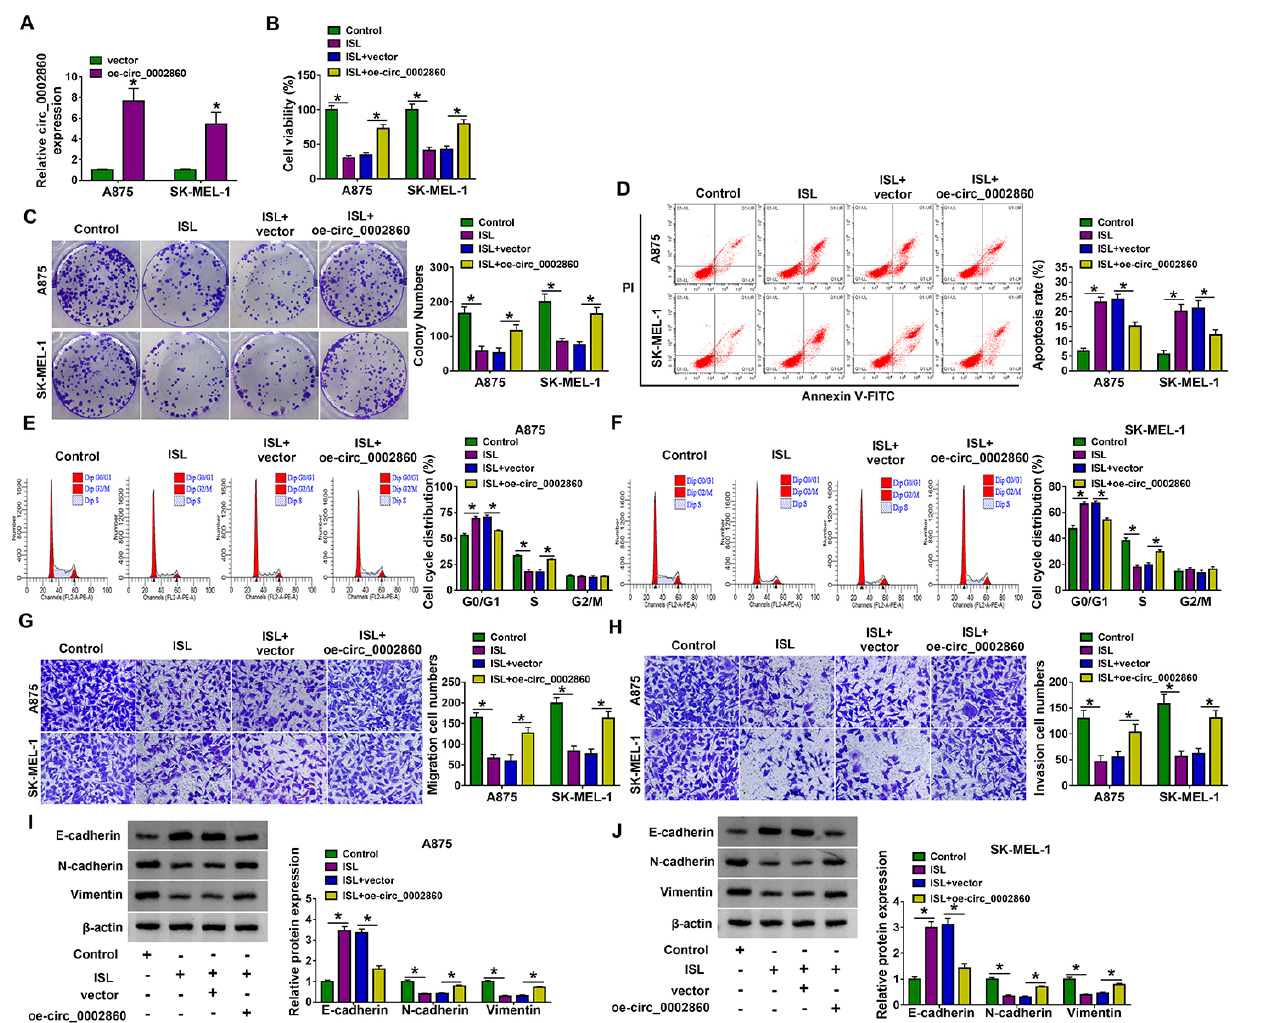
Figure 2. ISL impeded proliferation, cell cycle progression, migration and invasion of melanoma cells via inhibiting circ_0002860. (A) The expression analysis of circ_0002860 was performed via RT-qPCR in vector or oe-circ_0002860 transfected A875 and SK-MEL-1 cells. A875 and SK-MEL-1 cells were treated with control, ISL (60 µg/mL), ISL+vector, ISL+oe-circ_0002860. (B) Cell viability examination was performed via CCK-8 assay. (C) Cell proliferation detection was conducted by colony formation assay. The determination of (D) cell apoptosis and (E, F) cell cycle was performed by flow cytometry. The evaluation of (G) migration and (H) invasion was conducted via transwell assay. (I, J) The measurement of EMT-related proteins was performed via western blot. * p <